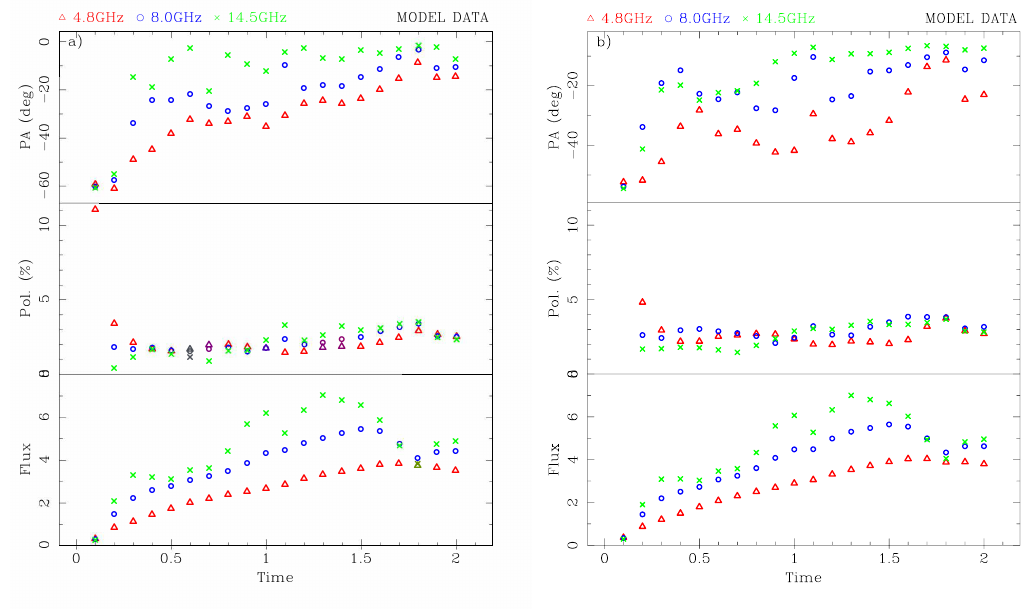
Figure 6. Simulated T1985 light curves with the addition of a strong helical magnetic field component. Panel ( a ) shows the result for a helical field of strength comparable to that of the random component (an order multiple of 1.0, see text) and panel ( b ) shows the result for a helical field with strength that dominates over the random component (an order multiple of 10). Time is shown in arbitrary